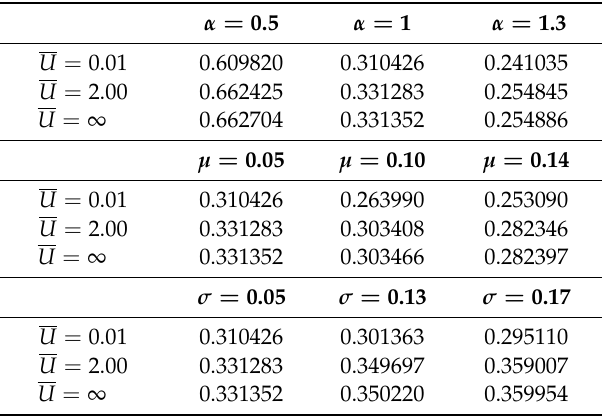
Table 4. Effect of α , µ and σ on the optimal debt ceiling b